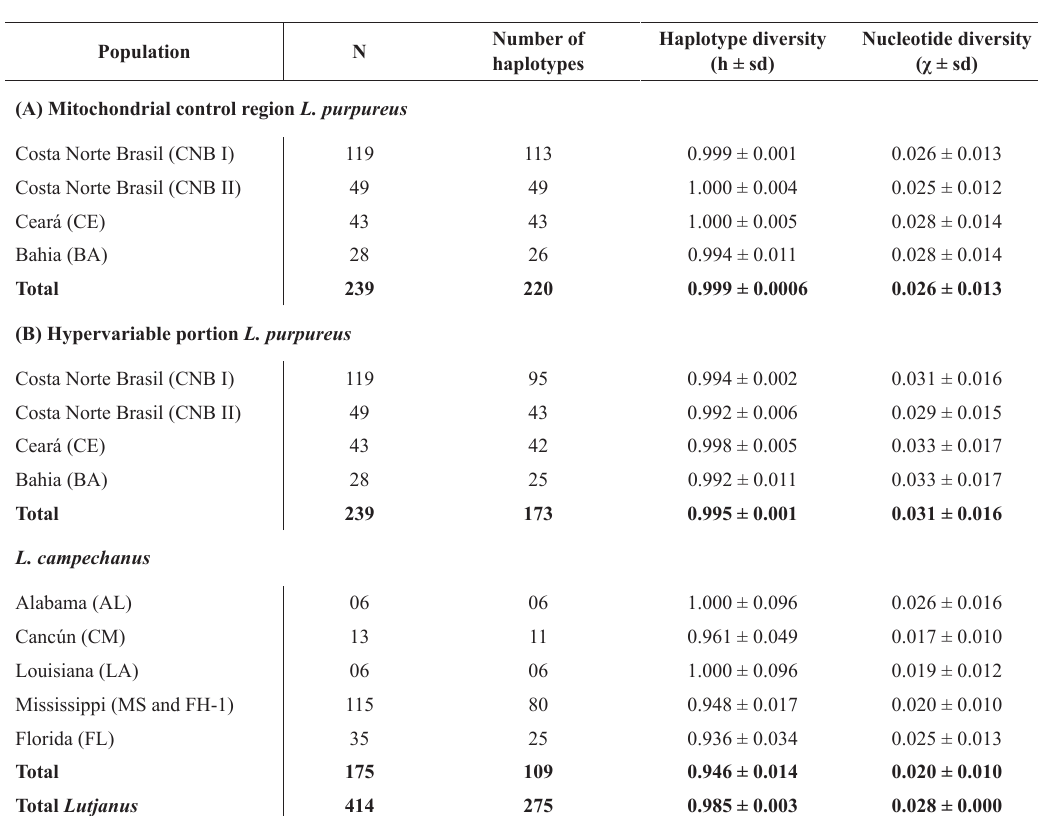
Sample size, number of haplotypes and indices of nucleotide and haplotype diversity for: (A) the mitochondrial control region in Brazilian L. purpureus , and (B) the hypervariable portion of the control region in Brazilian L. purpureus (present study) and L. campechanus sampled by Garber et al.